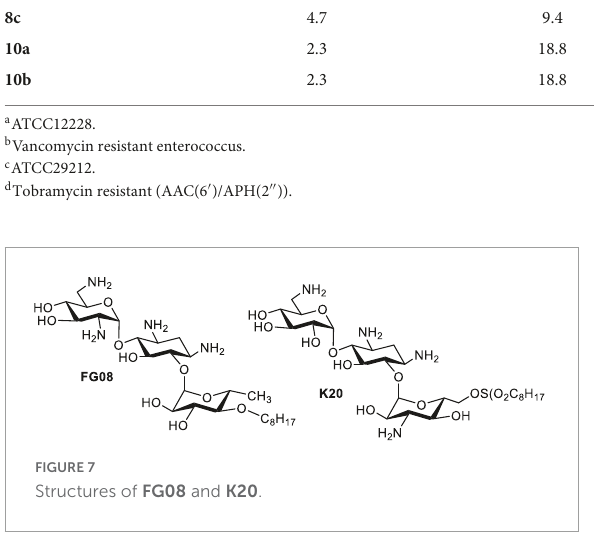
FIGURE7 Structures of FG08 and K20 .